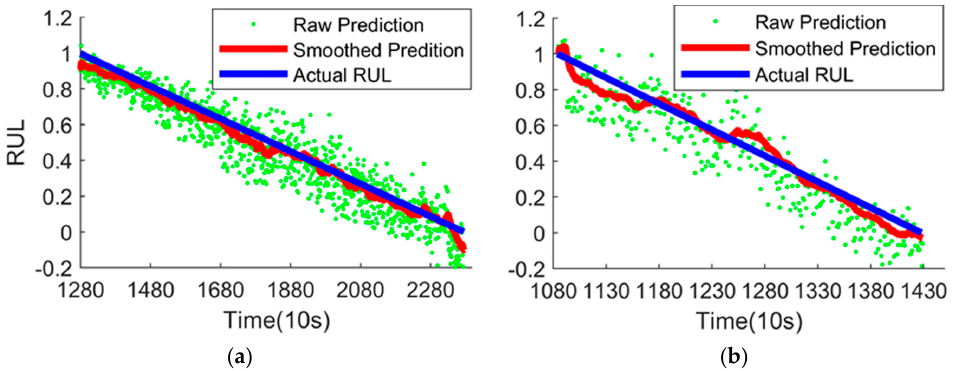
Figure 8. RUL prediction results of the test sets. ( a ) RUL prediction results of the Bearing1_3 by the proposed method; ( b ) RUL prediction results of the Bearing1_4 by the proposed method.